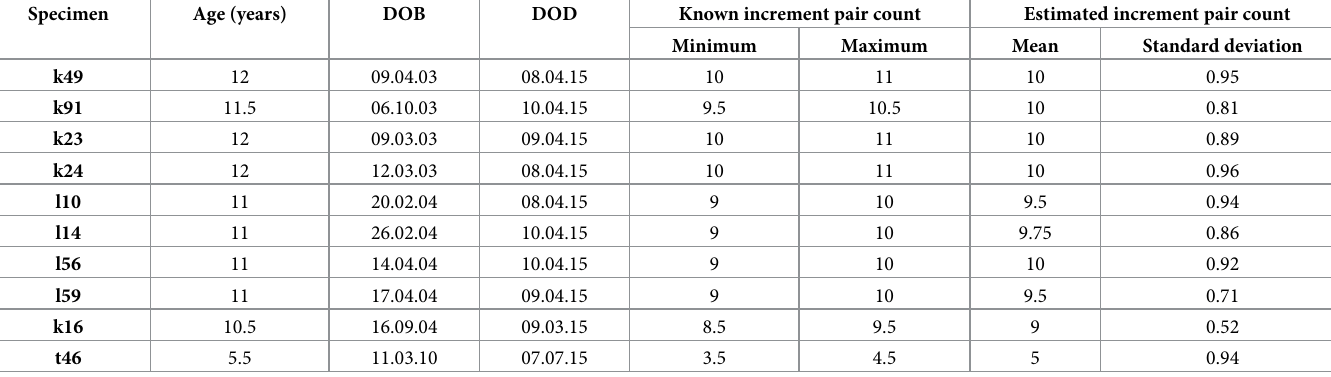
DOB = date of birth; DOD = date of death. Mean increment pair counts are rounded to the nearest 0.25 years for comparison with known increment pair counts.